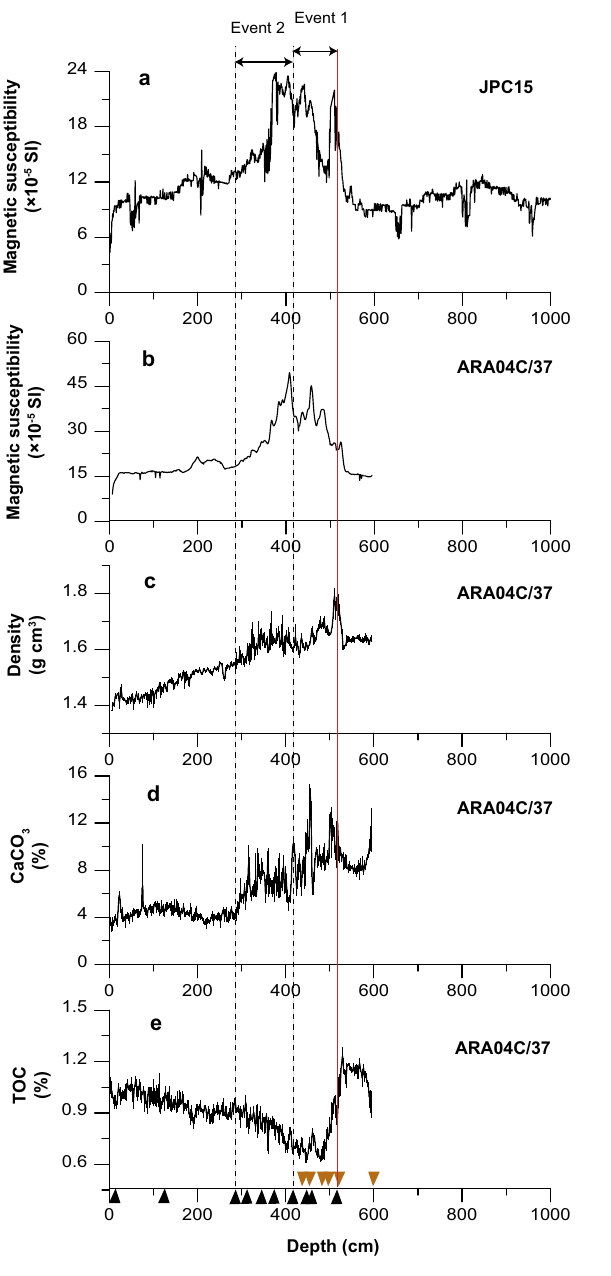
Fig. 5 Physical properties and chemical records showing two major events. a Magnetic susceptibility from Core JPC15 19 . Exhibit records from Core ARA04C/37, b magnetic susceptibility, c density, d CaCO 3 content (see “ Methods ” ), e TOC content. The vertical lines and horizonal arrows indicate the range of depth recording the two major events. The red vertical line aligns the same AMS 14 C dates from both cores, which indicates a good age constraint of magnetic susceptibility rise. Triangles refer to AMS 14 C dates used in the age – depth model, black triangles from Core ARA04C/37 (this study) and brown triangles from Core JPC15 19 . representing two periods of MIZ situations (see details in “ Discussion ” ). Deglacial – Holocene changes in freshwater discharge . Synchro- nous changes (Fig. 6d, e) as well as the positive correlation (Supplementary Fig. 1a) between terrigenous biomarkers (cam- pesterol and ß-sitosterol) and brassicasterol suggest that